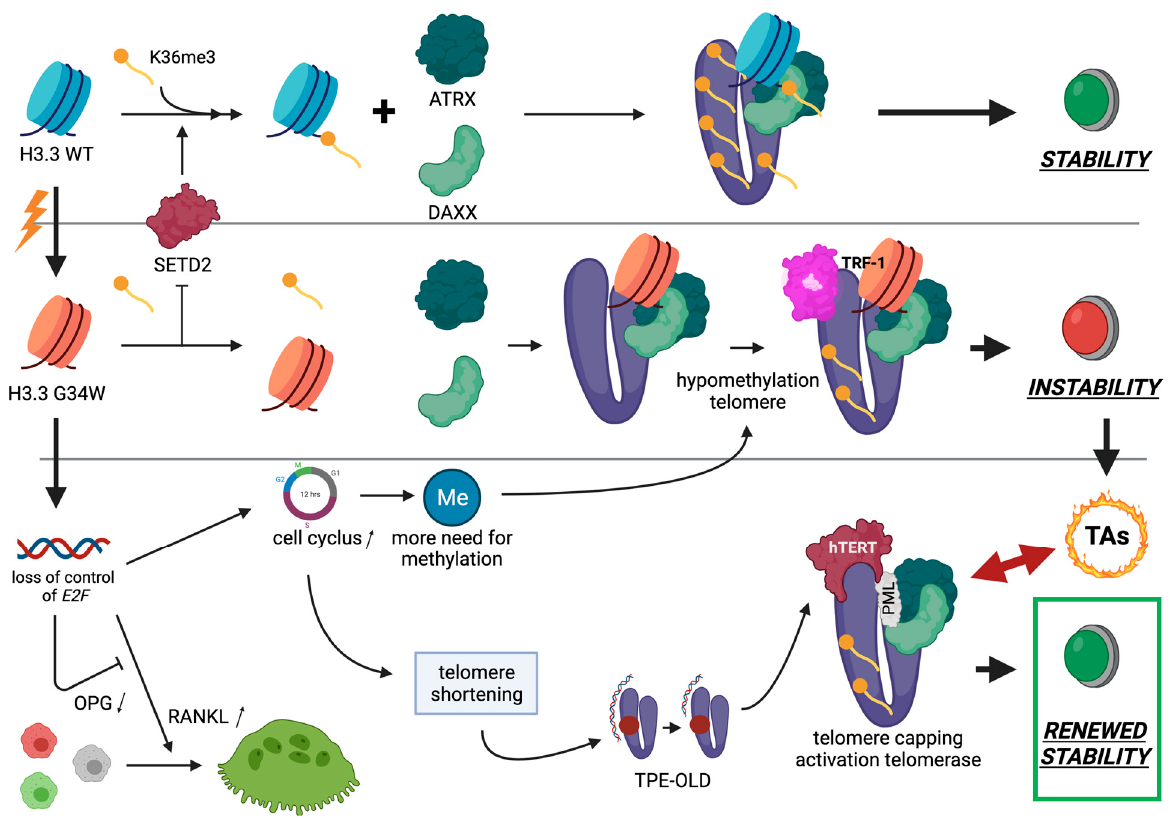
Figure 3. Cell biology of GCTB. See left upper corner. Mutation leading from wild-type H3.3 (blue) to H3.3G34W (orange) inhibits the activity of the histone methyltransferase SETD2, which is in normal circumstances responsible for H3K36me3 of the histone tail. Wild-type H3.3 telomeres (purple) are sufficient methylated, and form together with ATRX and DAXX stable telomere ends. In contrast, affecting the H3.3-G34W terminal tail leads to a relative hypomethylation status. The loss of the telomeric H3K36me mark could favour the binding of TRF-1 to telomeres resulting in a relative telomeric instability further leading to mainly sister–sister TAs. In H3.3G34W mutated stromal cells E2F targets are the most downregulated genes. This suggests that the high proliferative activity of these mutated cells may be the result of silencing negative regulators of the cell cycle, most probably the E2F4-6 family members. When taking the GCTB-relevant genes targeted by the E2F transcription factors into account, RANKL and osteoprotegrin (OPG) are differentially targeted which leads to a loss of E2F control resulting in secretion of high levels of RANKL together with reduced levels of its decoy receptor OPG, and therefore to an enhanced osteoclastogenesis. Due to a higher proliferative activity there is more need for methylation of the telomeres, while these hypomethylated telomeres shorten faster. As a result of this shortening, the silencing loop structure of TPE-OLD is no longer in the proximity of hTERT, leading to hTERT transcription and telomerase activity. Together with the formation of a structural telomere protective cap (PML/ATRX/DAXX) this whole mechanism plays a pivotal role in successful and stable telomere maintenance leading to a renewed telomeric and hereby genomic stability.